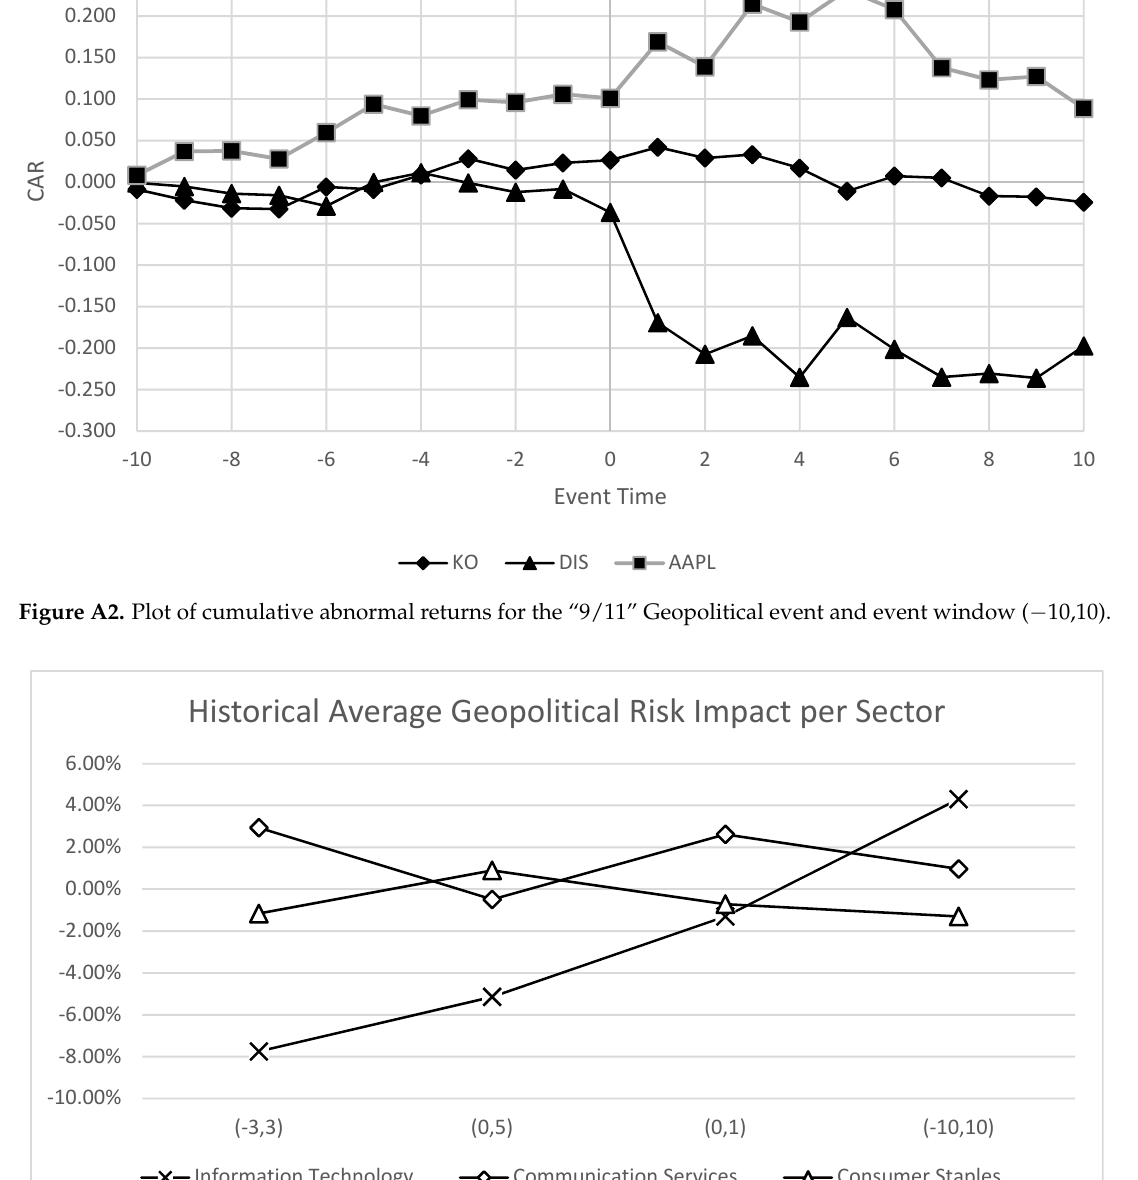
Figure A3. Overview of the impact of geopolitical risk (Historical Sector Average CAAR) on the Information Technology, Communication Services, and Consumer Staples sectors.